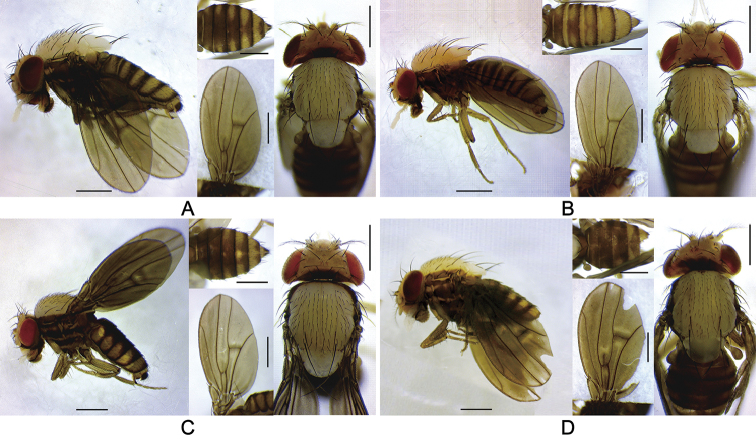
Left lateral habitus, thorax, wing, and abdomen of Dudaica species (part 1). Amalayana (Takada) (#03904) Bgracilipalpis sp. n. (paratype #03902) Cpuberula sp. n. (holotype #03365) Dalbipalpis (holotype #03908). Scale bars: 0.5 mm.